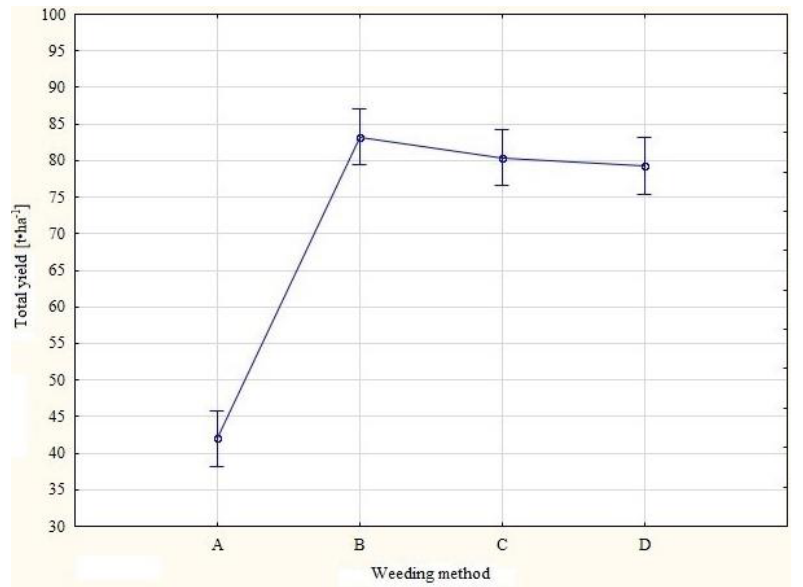
Figure 4. Expected marginal averages for 0.95 confidence intervals in total onion yield in 2016 (source: own work).